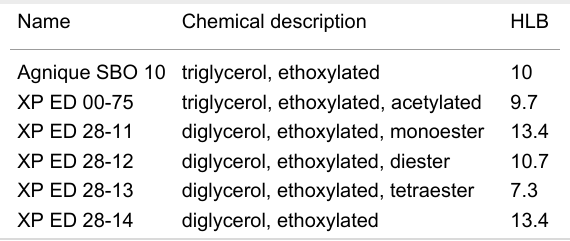
Table 1: Surfactants used for leaf surface